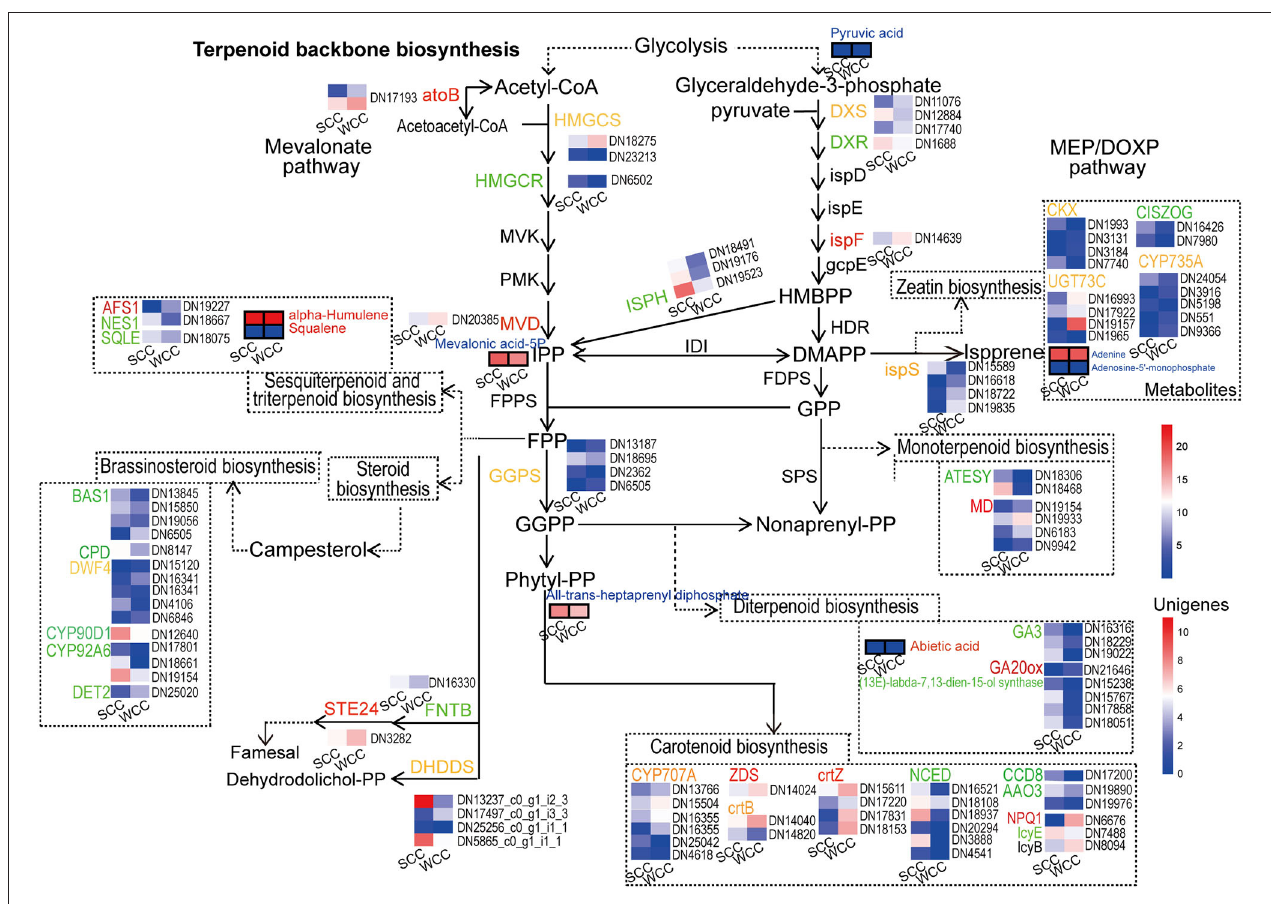
FIGURE 7 | Metabolic pathway map of terpenoid-related biosynthesis pathways. SCC and WCC represent summer and winter C. fortunei needles, respectively. Small squares without/with lines indicate the expressed levels of unigenes/metabolites, and red/green/yellow text indicates up/down/both up- and downregulated genes or metabolites in WCC needles. The abbreviation of each gene is as follows: AAO3 , abscisic-aldehyde oxidase ; AFS1 , alpha-farnesene synthase ; ATESY , alpha-terpineol synthase ; atoB , acetyl-CoA acetyltransferase ; BAS1 , PHYB activation tagged suppressor 1 ; CCD8 , carlactone synthase ; CISZOG , cis-zeatin O-glucosyltransferase ; CKX , cytokinin dehydrogenase ; CPD , cytochrome P450 family 90 subfamily A polypeptide 1 ; crtB , 15-cis-phytoene synthase ; crtZ , beta-carotene 3-hydroxylase ; CYP707A , ( + )-abscisic acid 8’-hydroxylase ; CYP735A , cytokinin trans-hydroxylase ; CYP90D , 1,3-epi-6-deoxocathasterone 23-monooxygenase ; CYP92A6 , typhasterol/6-deoxotyphasterol 2alpha-hydroxylase ; DET2 , steroid 5-alpha-reductase ; DHDDS , dehydrodolichyl diphosphate synthase ; DWF4 , steroid 22-alpha-hydroxylase ; DXR, 1-deoxy-d-xylulose 5-phosphate reductoisomerase ; DXS , 1-deoxy-D-xylulose-5-phosphate synthase ; FNTA , farnesyltransferase alpha ; GA20ox , gibberellin 20-oxidase ; GGPS , geranyl diphosphate synthase ; HMGCR , 3-hydroxy-3-methylglutaryl-CoA reductase ; HMGCS , hydroxymethylglutaryl-CoA synthase ; ispF , 2-C-methyl-D-erythritol 2,4-cyclodiphosphate synthase ; ispH , 4-hydroxy-3-methylbut-2-en-1-yl diphosphate reductase ; ispS , isoprene synthase ; MD